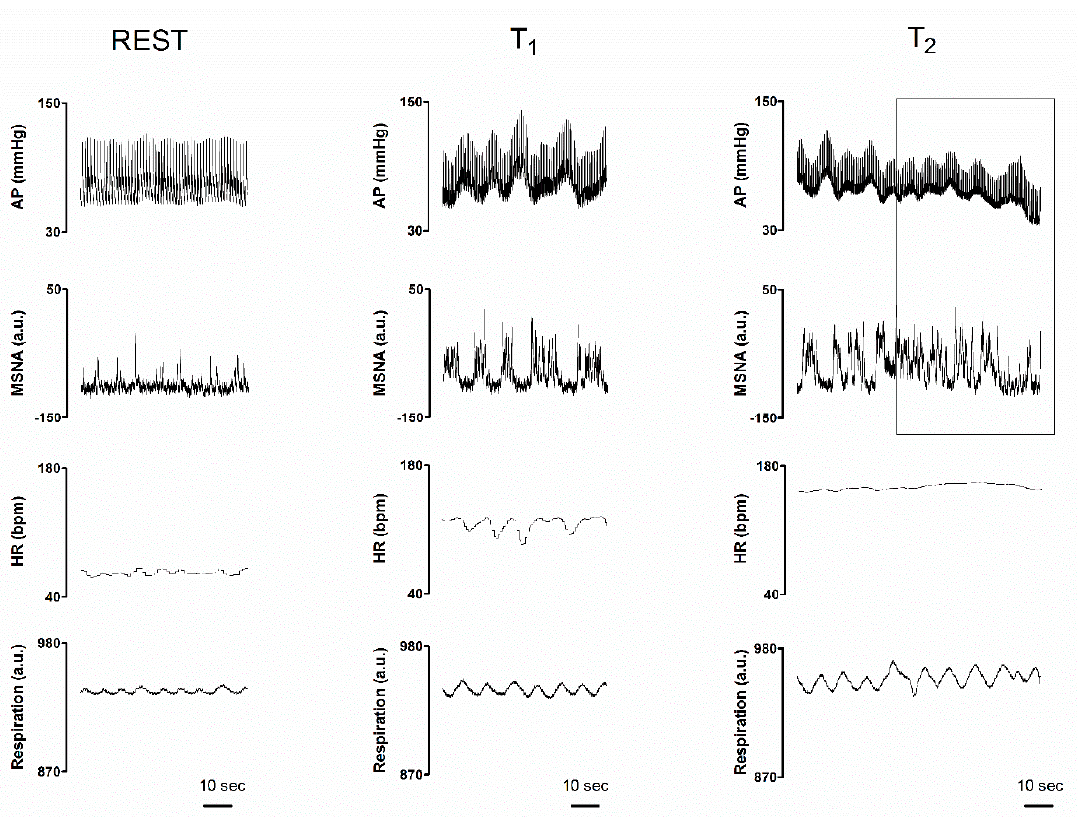
Figure 1. Individual traces of arterial pressure (AP), integrated muscle sympathetic nerve activity (MSNA), heart rate (HR) and respiratory activity (Respiration), recorded in a representative subject while supine (REST), during the asymptomatic phase of a 80 ◦ head-up tilt (T 1 ) and during late tilt just before the pre-syncope onset (T 2 ). The right squared window highlights the pre-syncope changes: notice the enduring but chaotic neural sympathetic discharge activity as compared with MSNA trace at T 1 characterized by rhythmic sympathetic firing at 0.1 Hz (i.e., a cycle every 10 s); also, please note the concomitant progressive hypotension in spite of the compensatory tachycardia and sympathetic neural activity to the vessels (see above for further explanations). Table 1. Hemodynamic parameters, respiratory activity and sympathetic post-ganglionic discharge activity (MSNA) while supine (REST), during the asymptomatic phase of tilt (T 1 ) and the period of tilt just preceding syncope (T 2 ). Values are expressed as mean ± standard